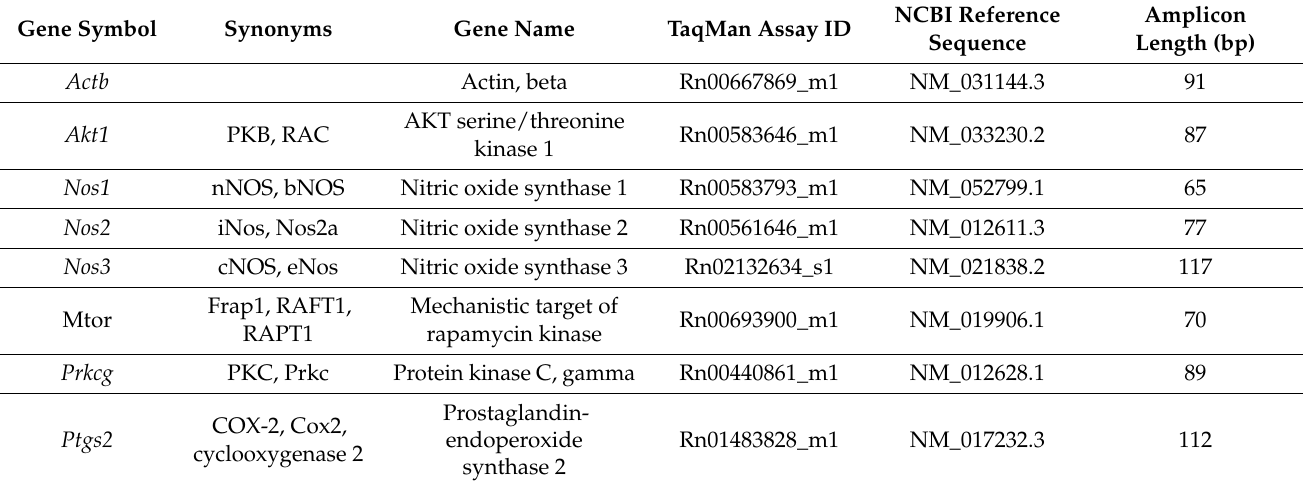
Table 1. Selected genes and TaqMan Assay